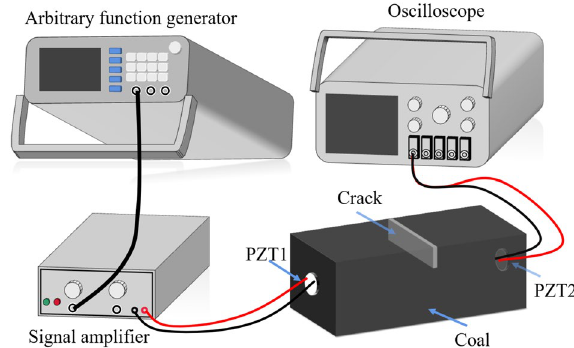
Figure 3. Experimental process diagram.